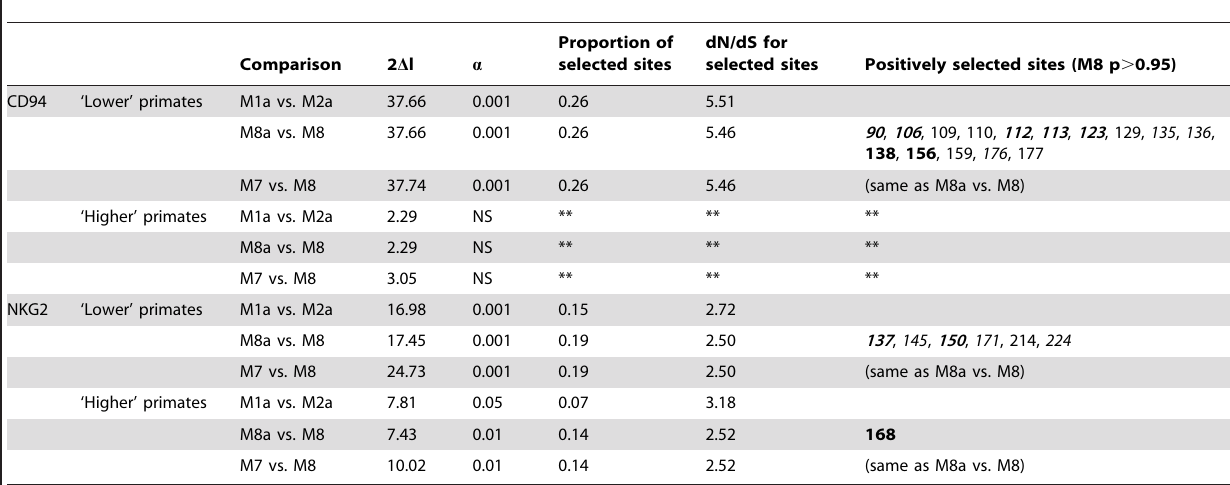
Table 1. Natural selection diversified CD94 and NKG2 residues in ‘‘lower’’ primates, but not in ‘‘higher’’ primates.